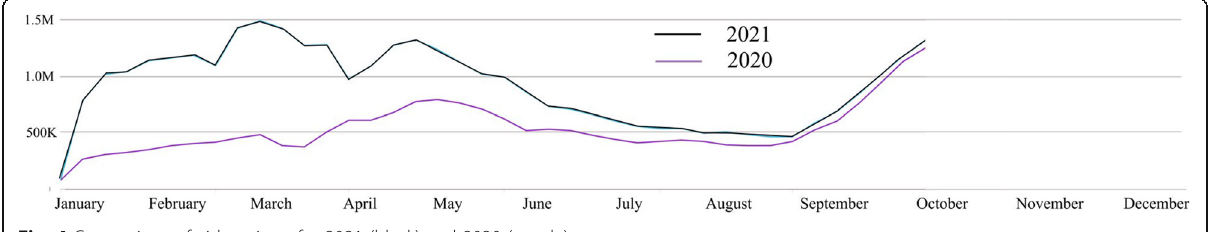
Fig. 4 Comparison of video views for 2021 (black) and 2020 (purple)